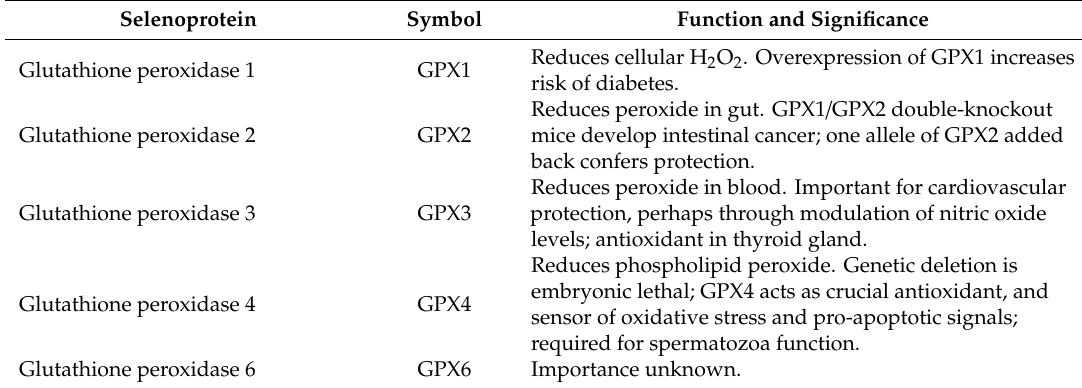
Table 1. Functions and significance of